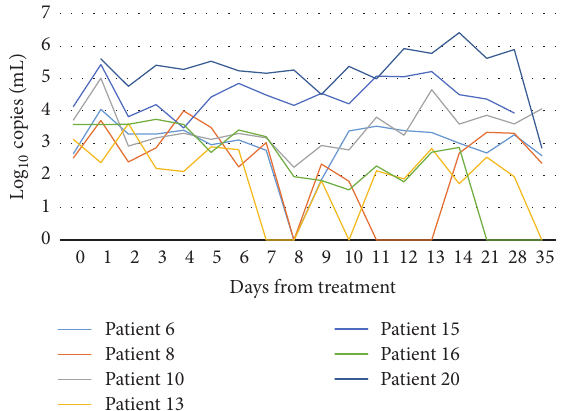
Figure 3: Bacterial load in participants infected with an A2059G mutation. Some patients had sporadic negative samples during the test